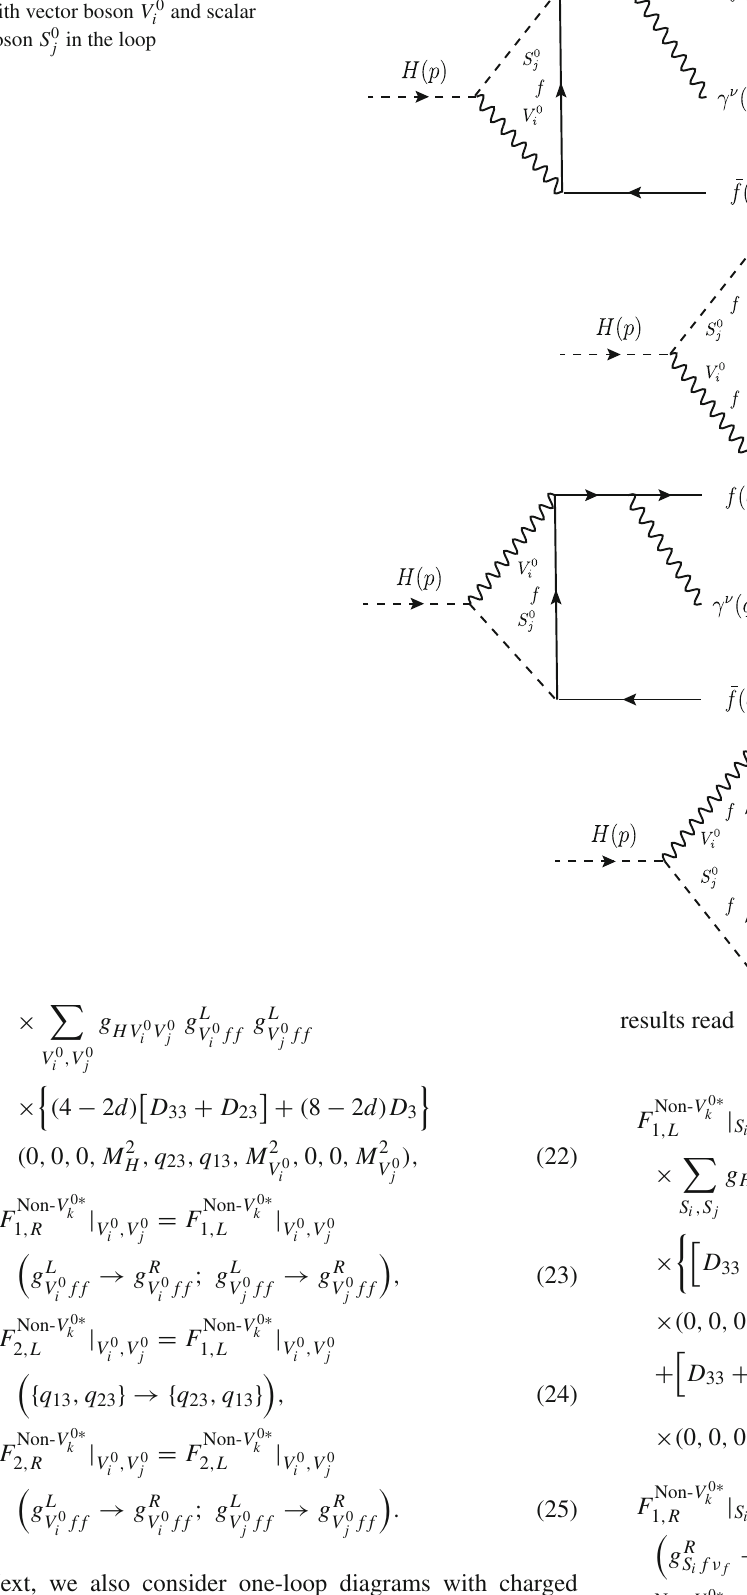
Fig. 12 One-loop diagrams with vector boson V 0 and scalar i boson S 0 in the j